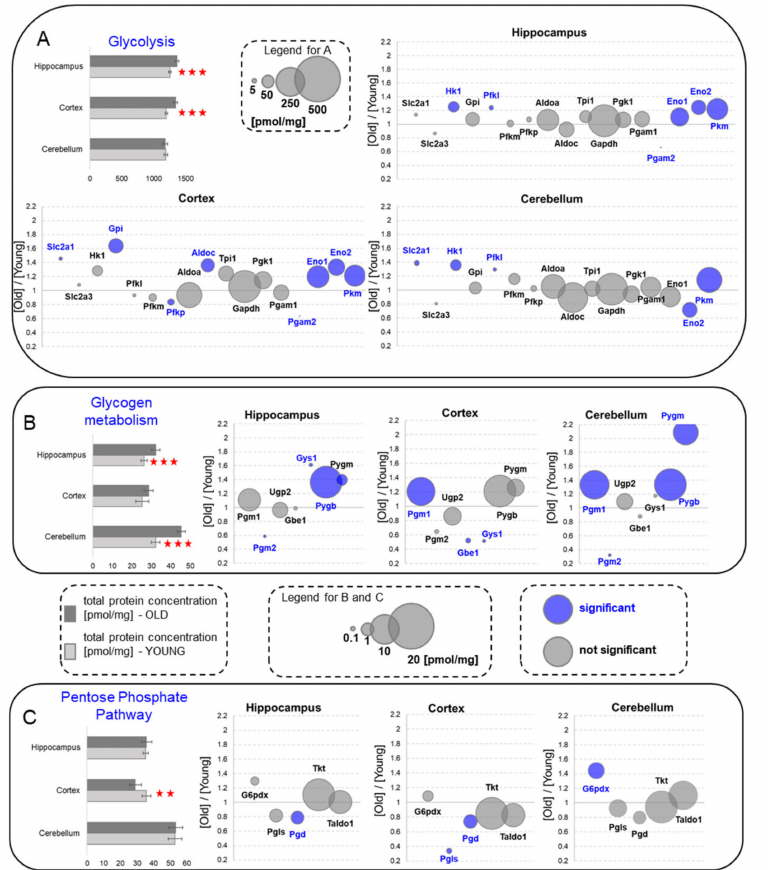
Figure 3. Changes in the energy metabolism processes upon aging—glucose and glycogen as energy sources. ( A ) Glucose transporters and glycolysis. ( B ) Glycogen metabolism. ( C ) Pentose Phosphate Pathway. Column plots show total protein concentration summarizing each metabolic pathway for young and old animals in the hippocampus, cortex, and cerebellum. The statistically significant changes between the age groups are indicated (** p < 0.01, *** p < 0.001). Bubble plots show ratios of protein concentrations in the old vs. young hippocampus, cortex and cerebellum. The size of the bubbles is proportional to an average protein concentration. Proteins with significantly changed concentrations are highlighted in blue. Abbreviations: YOUNG—1-month-old and OLD—22-month- old